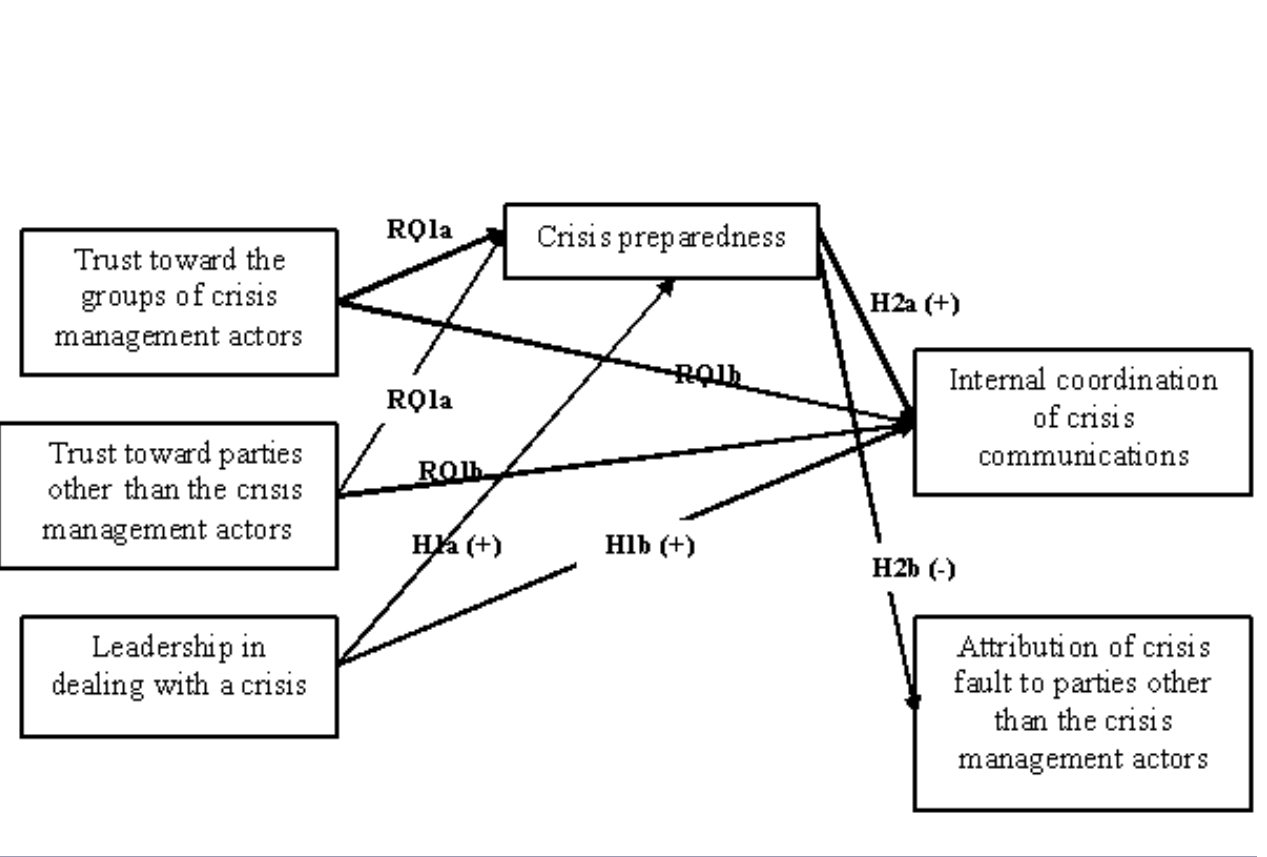
Fig. 1. Model A: Proposed baseline model of crisis communication management, with hypothesis